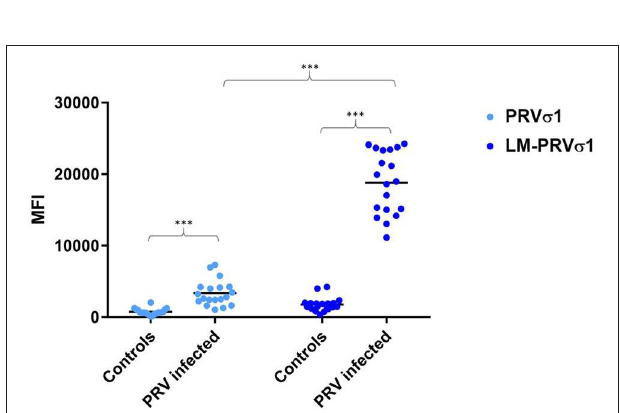
FIGURE 2 | Increased detection of anti- σ 1 using lipid modified antigen. Comparison between beads coated with σ 1 and beads coated with LM- σ 1 when used in the immunoassay to analyze plasma from PRV-infected Atlantic salmon (12–15 wpc) and controls. Significant difference between infected and control fish, and between different antigens when used to analyse infected fish samples are indicated by asterisks (Mann-Whitney